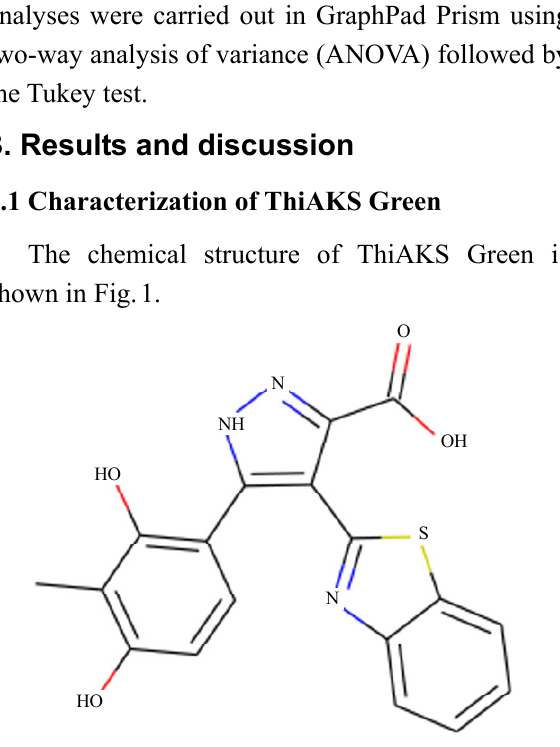
Fig. 1 Chemical structure of ThiAKS Green, 1H-pyrazole- 3-carboxylic acid, 4-(benzo[d]thiazol-2-yl)-3-(2,4-dihydroxy-3- methylphenyl)-1H-pyrazole-5-carboxylic acid4-(2- benzothiazolyl)-5-(2,4-dihydroxy-3-methylphenyl). (Taken from ZINC database) CAS Registry number: 384367-09-3.